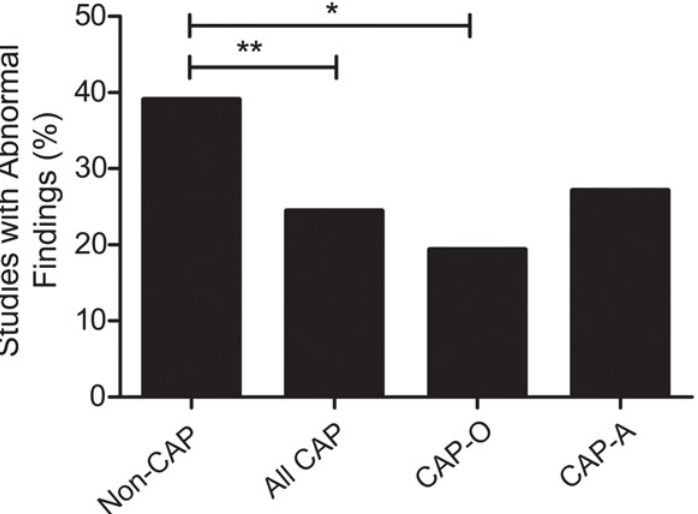
Fig 2. Abnormal findings in those receiving VCE for CAP versus those receiving VCE studies for all other indications (non-CAP). CAP-O represents CAP with no other symptoms. CAP-A represents CAP and any associated symptoms (See Methods for description). * represents a p-value of < 0.05. ** represents a p- value of <